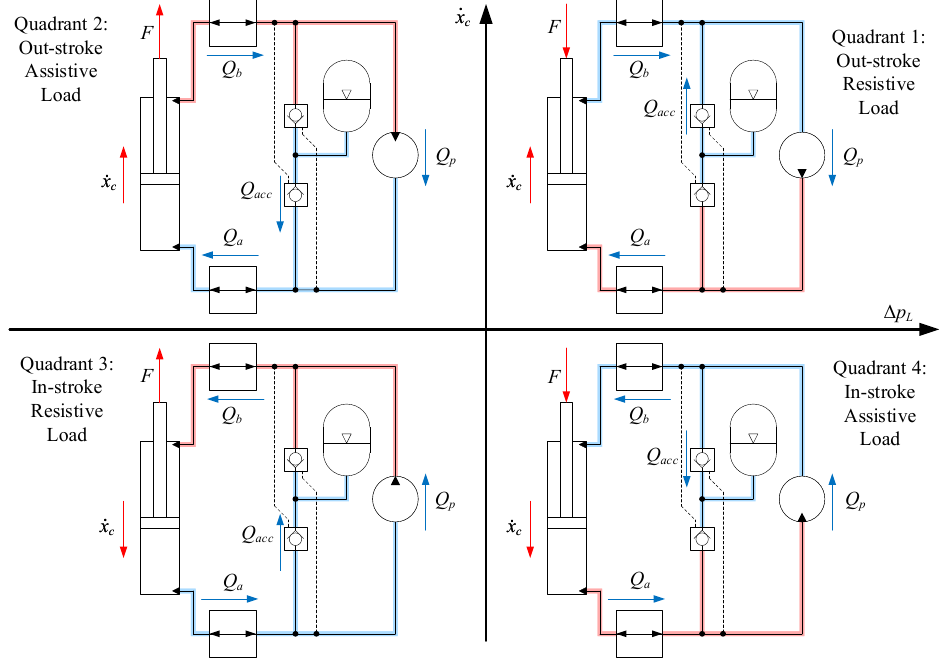
Figure 3. Four-quadrant operation of the simplified circuit with load holding valves energized.